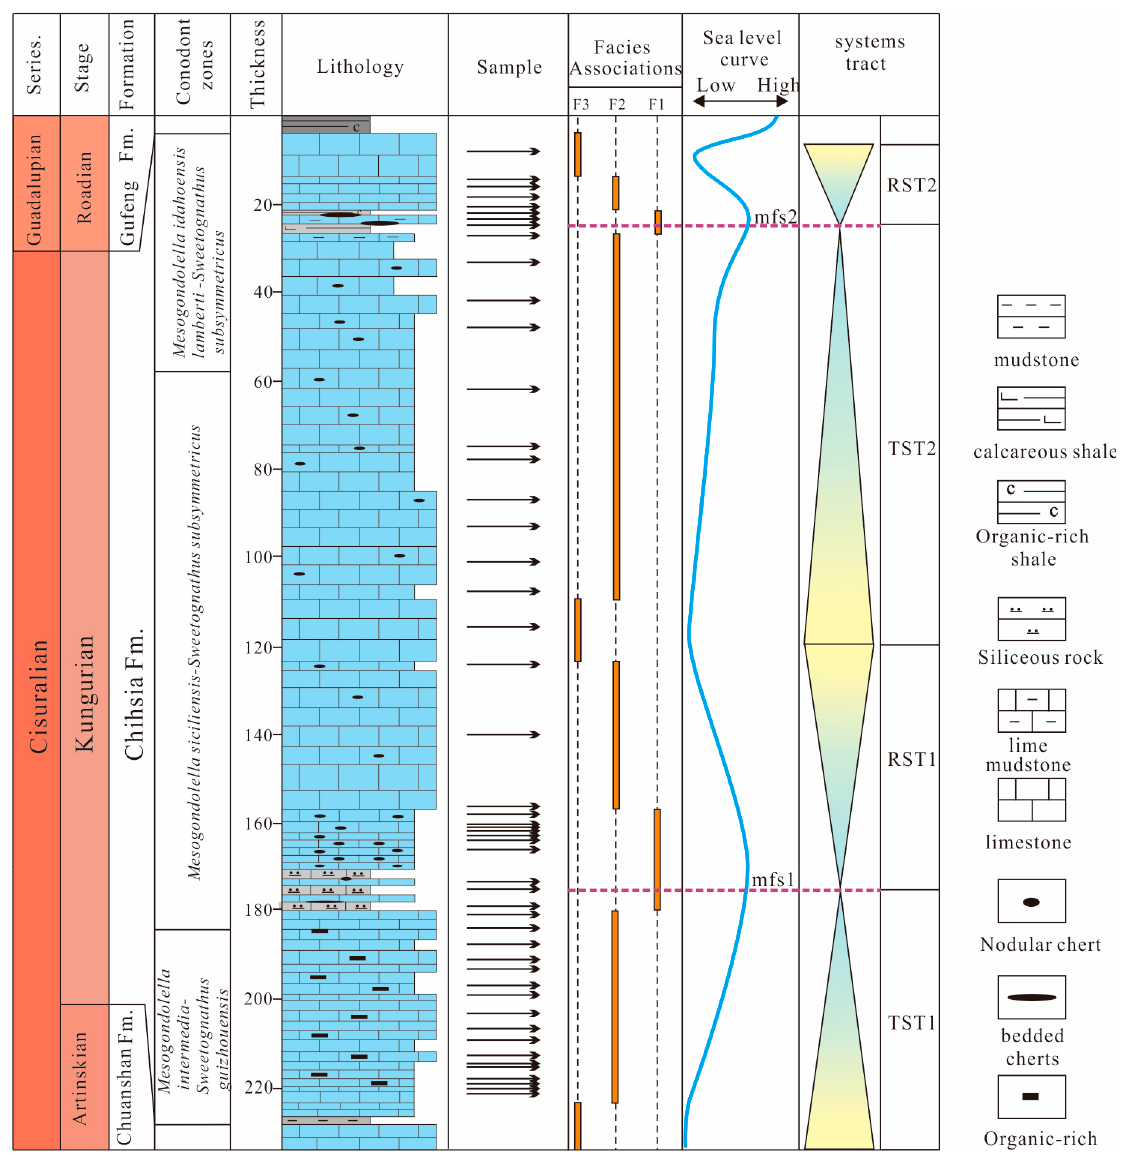
Figure 2. The lithostratigraphy, sedimentary facies, and sampling location at the Putaoling section of Chaohu during the Kungurian (paleontological data modified from [25]). mfs represents the maximum flooding surface.